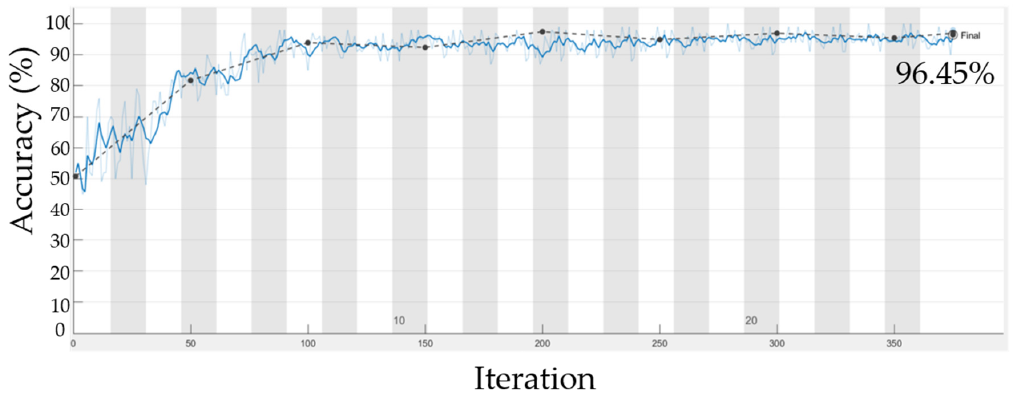
Figure 12. The learning curve of deep learning for hyperspectral data. (The horizontal axis shows the iteration and the vertical axis shows the accuracy of classification. The blue line shows the accuracy for the learning data set and the black dots represent the accuracy for the verification data set).